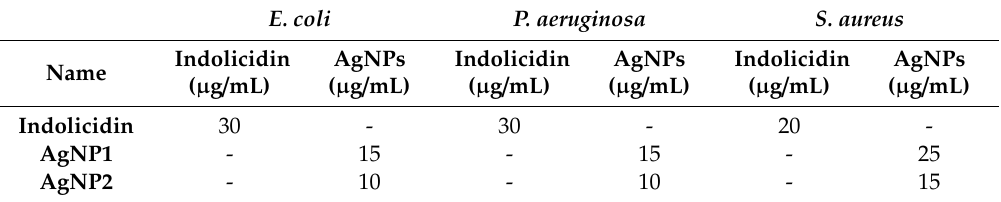
Table 5. Antibacterial activity of indolicidin and AgNPs alone against Gram-positive and negative bacteria. The antibacterial activity is expressed as MIC values.